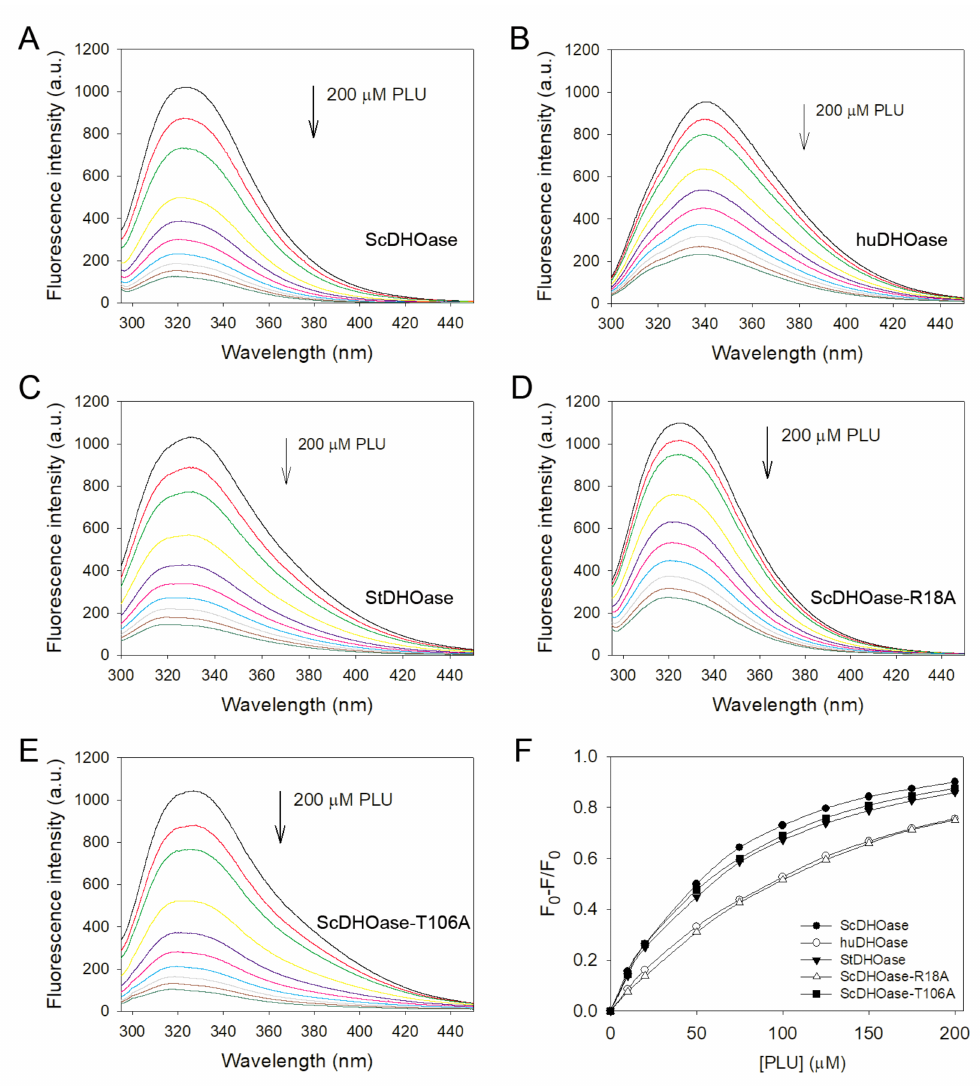
Figure 7. The data used to calculate the K d values of various DHOases. ( A ) The fluorescence emission spectra of ScDHOase with PLU of different concentrations (0–200 µ M; 0, 10, 20, 50, 75, 100, 125, 150, 175, and 200 µ M). The decrease in intrinsic fluorescence of protein was measured at 324 nm upon excitation at 280 nm with a spectrofluorometer. The fluorescence intensity emission spectra of ScDHOase significantly quenched with PLU. ( B ) The fluorescence emission spectra of huDHOase with PLU of different concentrations (0–200 µ M). ( C ) The fluorescence emission spectra of StDHOase with PLU of different concentrations. ( D ) The fluorescence emission spectra of ScDHOase–R18A with PLU of different concentrations. ( E ) The fluorescence emission spectra of ScDHOase–T106A with PLU of different concentrations. The huDHOase, StDHOase, ScDHOase–R18A, and ScDHOase–T106A individually displayed strong intrinsic fluorescence with peak wavelengths of 340, 330.5, 324.5, and 328 nm when excited at 280 nm. ( F ) An aliquot amount of PLU was added to the enzyme solution to determine the K d . The K d was obtained by the following equation: ∆ F = ∆ F max − K d ( ∆ F /[PLU]). Data points are an average of 2–3 determinations within a 10%